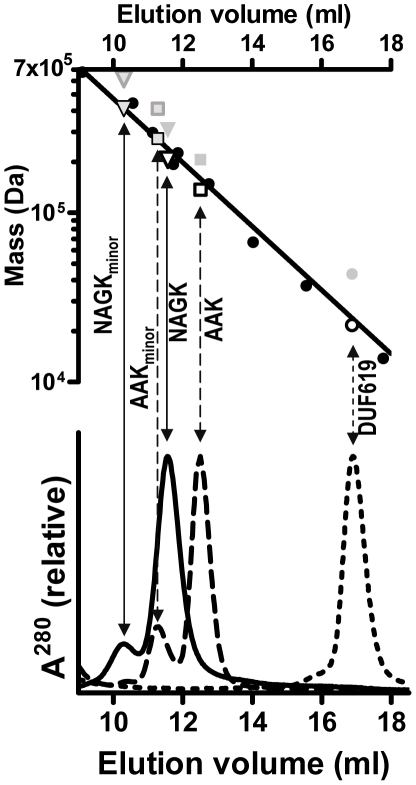
Size-exclusion chromatography of the complete enzyme and its isolated domains.The bottom panel illustrates the optical absorption (280 nm) of the effluent after injection to the Superdex 200 column of either complete NAGK (continuous line), AAK domain (broken line) and DUF619 domain (dotted line). The top panel illustrates a semi-logarithmic plot of molecular mass versus elution volume. Filled black circles correspond to the following protein standards (mass is given in kDa between parentheses): thyroglobulin (669), ferritin (440), NAGS from P. aeruginosa (294), β-amylase (224), NAGK from P. aeruginosa (191), alcohol dehydrogenase tetramer (147 kDa), bovine serum albumin (66), alcohol dehydrogenase monomer (37) and ribonuclease (14). Open-rimmed symbols plot the volumes of elution of the main peak for NAGK (inverted triangle) and for its AAK domain (square) versus their sequence-deduced masses if they were homotetramers, and for the DUF619 domain (circle) if it were monomeric (sequence-deduced masses 204, 132 and 21 kDa, respectively). Non-rimmed gray-filled symbols plot these positions for the sequence-deduced masses if NAGK and AAK were hexamers and if DUF619 were a dimer. Rimmed gray symbols correspond to the minor early peaks observed in the elution of NAGK and the AAK domain, by considering that both are octamers (black-rimmed) or dodecamers (gray-rimmed).